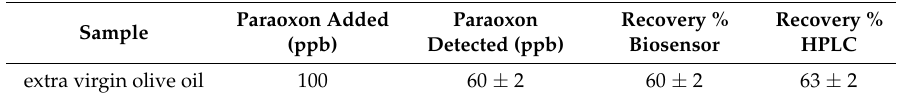
Table 1. Recovery study of paraoxon taken as a model compound of organophosphorus pesticides ( n = 3).